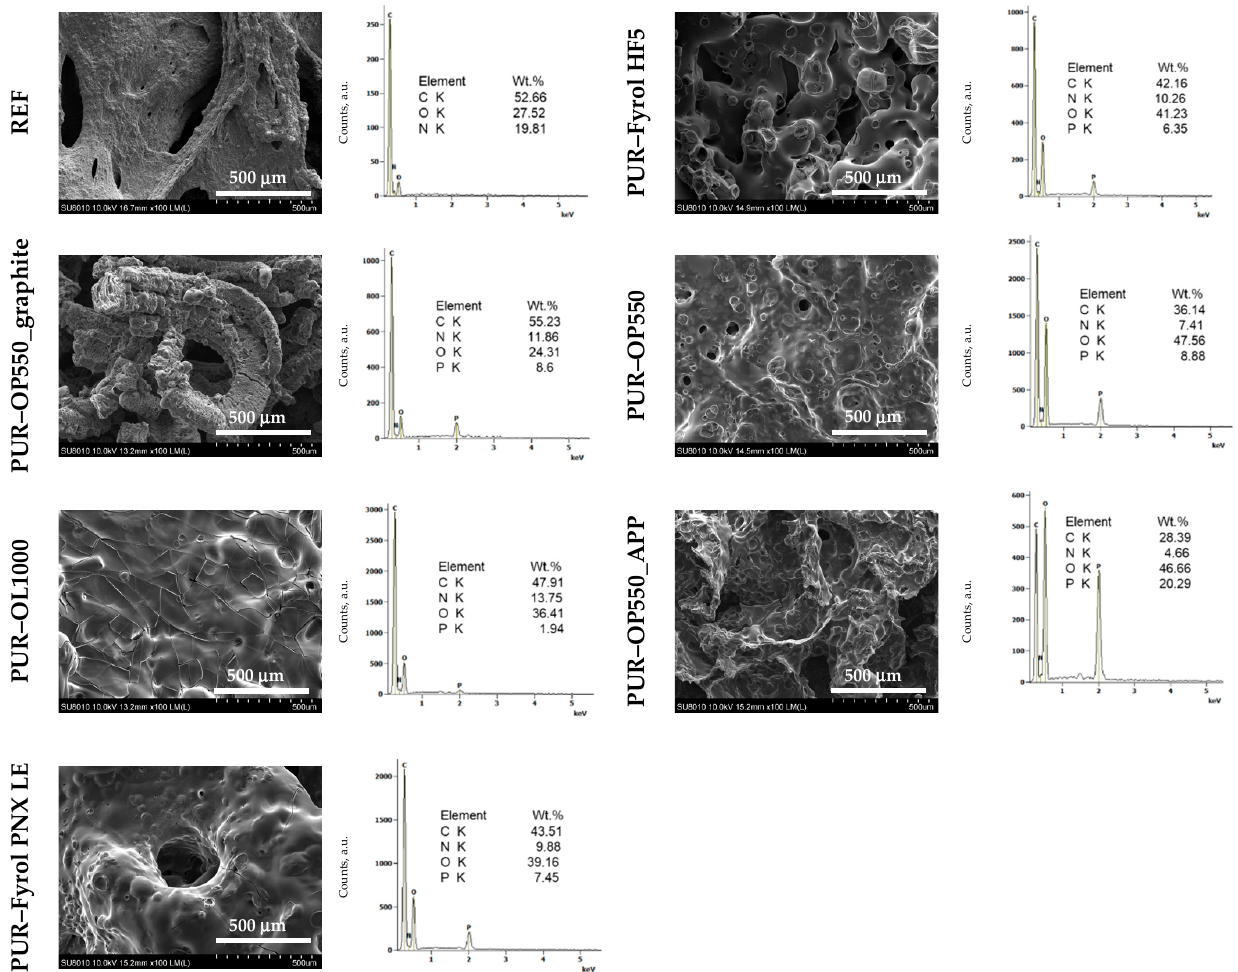
Figure 12. Scanning electron microscope images and energy dispersive spectroscopy results for foam samples after cone calorymetry tests.